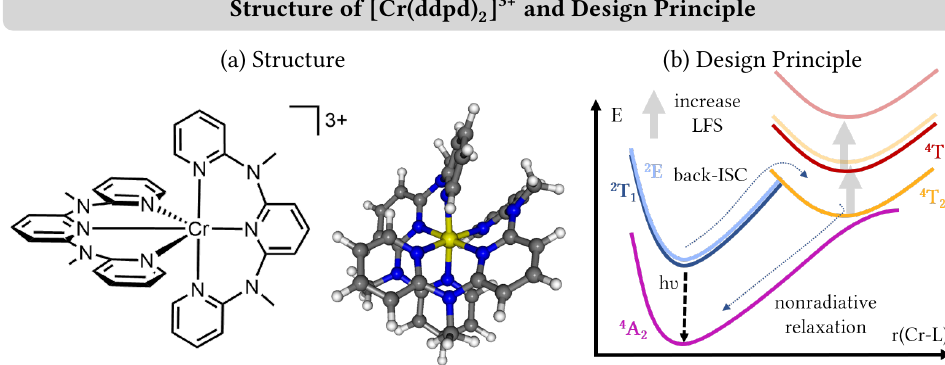
Figure 1. ( a ) Structure of [Cr(ddpd) ] 3+ . ( b ) Design principle of molecular rubies: by increasing the 2 ligand-field splitting (LFS) in octahedral chromium(III) complexes, back-intersystem crossing (ISC) from the low-lying 2 E + 2 T to the 4 T states at larger chromium–ligand bond lengths and subsequent 1 2 nonradiative relaxation to the 4 A ground state is quenched, resulting in increasing luminescence 2 yield. The gray arrows denote the effect of increased